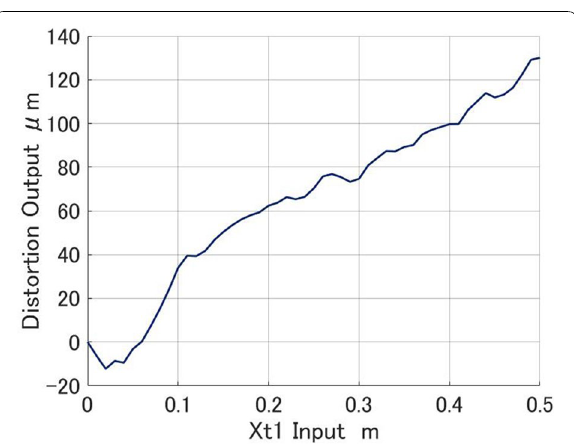
Fig. 3 Distortion of the gantry type linear motor